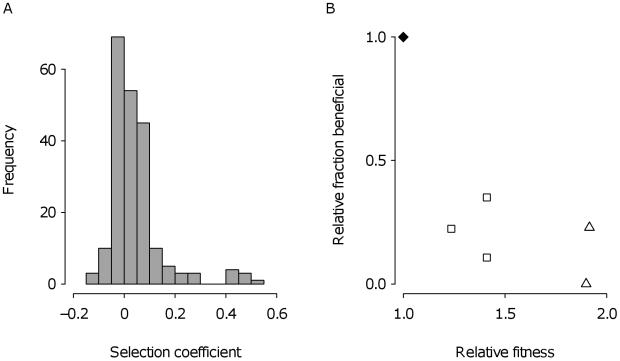
Mutations available to selection.(A) Distribution of selection coefficients among 210 isolates, each sampled from a predetermined position of a 5-d-old colony of the genotype used to found the selection experiment. (B) The relationship between the fraction of isolates that are beneficial and mean fitness of the genotype from which they were derived in two lineages from the large bottleneck treatment (scaled to the ancestor and corrected for false positives, see Materials and Methods and Figure S3). The fraction of isolates that are beneficial is reported relative to the fraction at the starting of the experiment. Symbols used correspond to those shown in Figure 2A. Fewer mutations were available to the final evolved types than the ancestor (Welch's two-sample t-test on proportions assuming unequal variance, low-fitness lineage: t
213.76 = −11.27, p<0.0001; high-fitness lineage: t
284.72 = −4.99, p<0.0001).